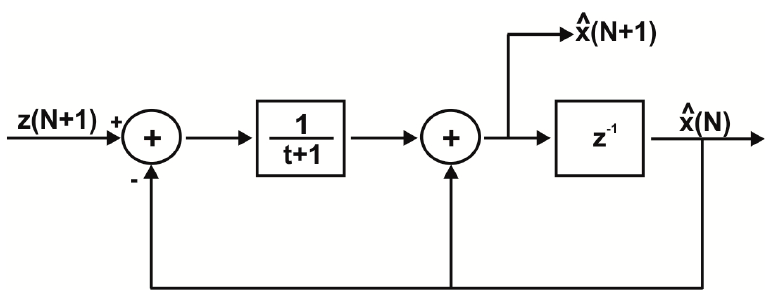
Figure 3. Real-time filter form